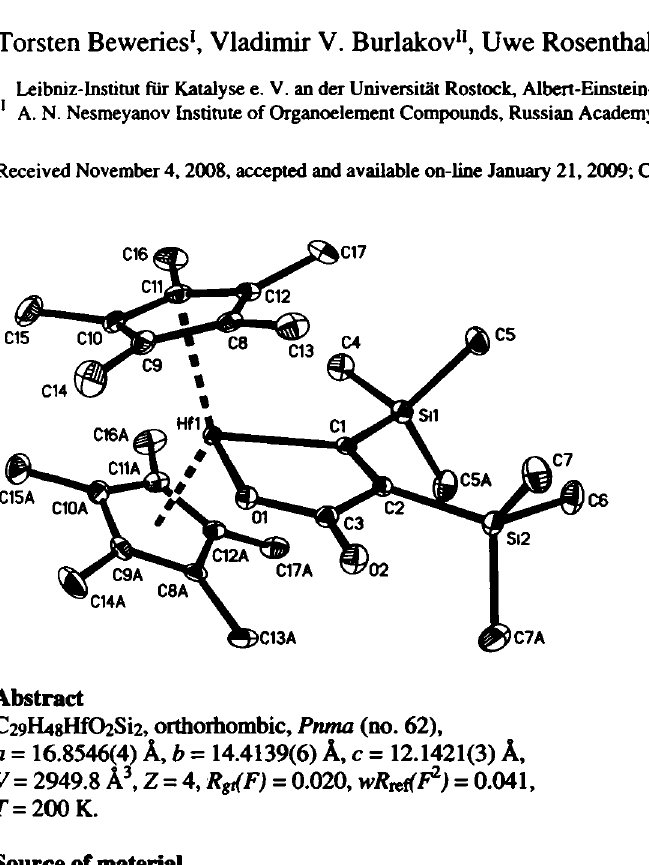
Table 2. Atomic coordinates and displacement parameters (in A 2